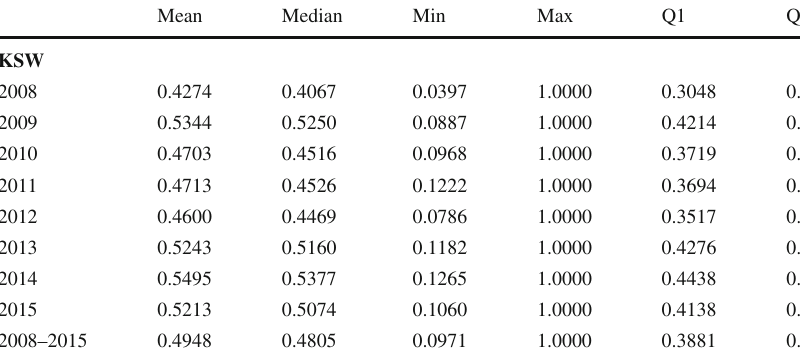
Fig. 4 Violin plots of cost efficiency estimates in